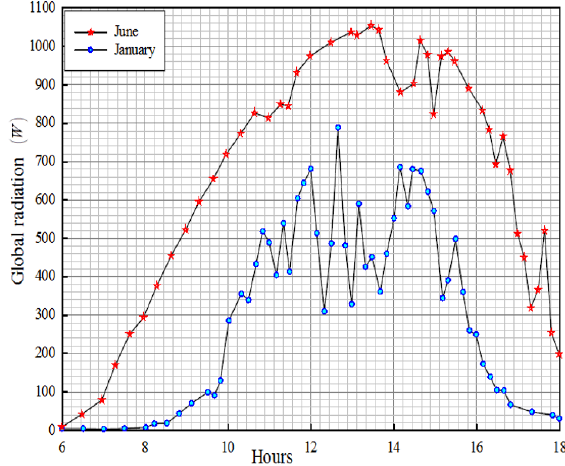
Figure 2. Variations of the global radiation vs. time in January and June.